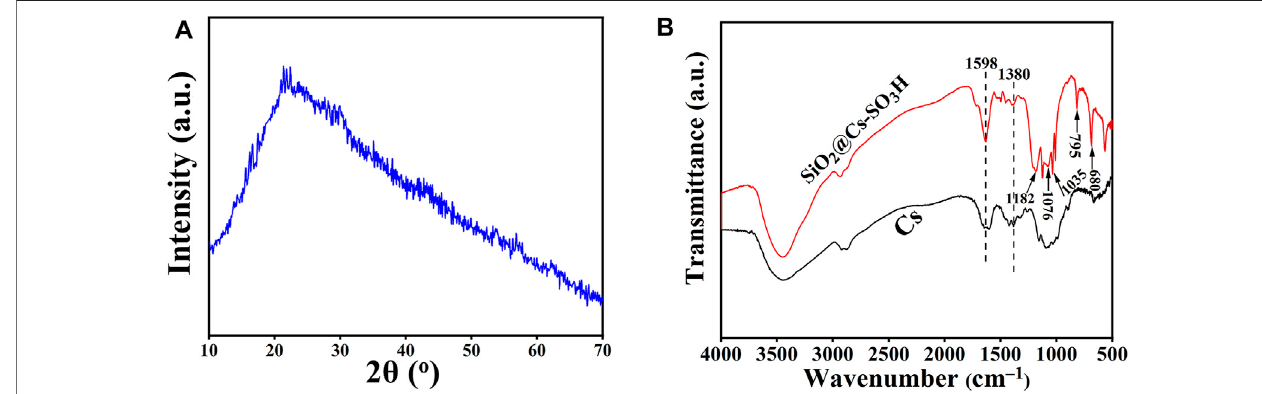
Frontiers in Chemistry |